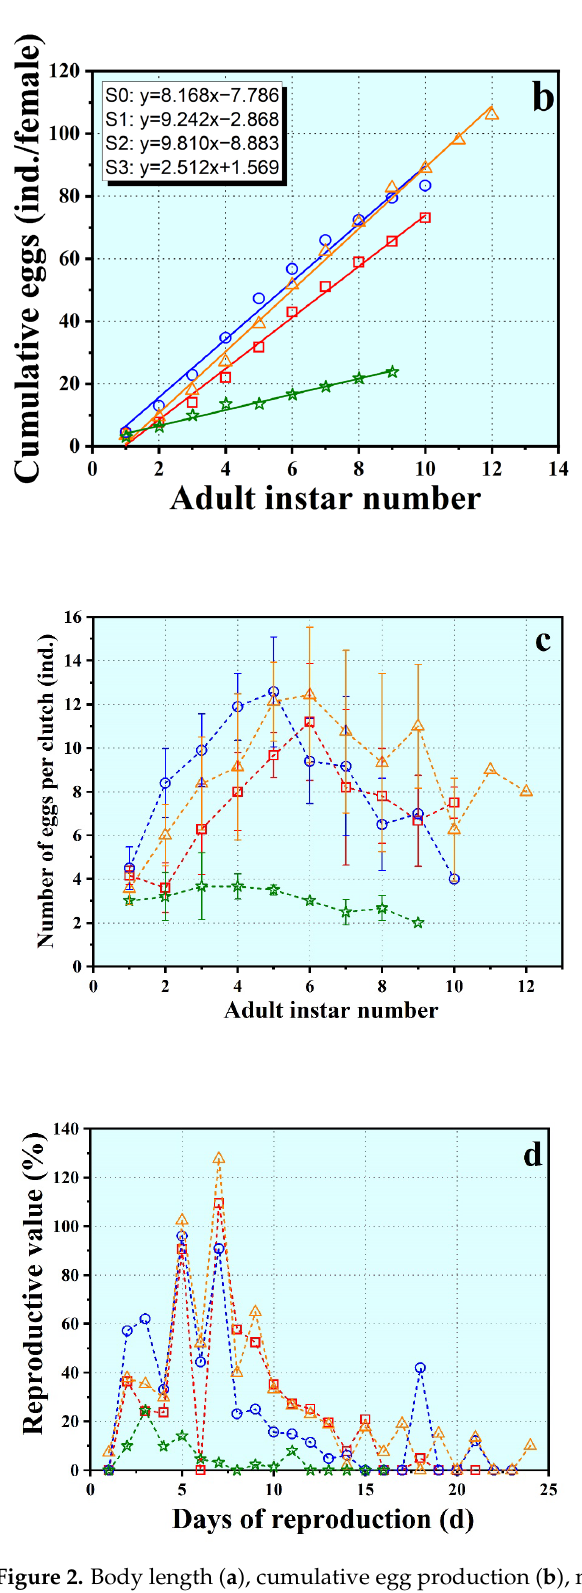
Figure 2. Body length ( a ), cumulative egg production ( b ), number of eggs per clutch ( c ) and repro- ductive value ( d ) of S. mucronata reared at different salinity gradients. Body length and number of eggs per clutch curves represent mean ( ± SE) values. S0, S1, S2, S3 and S4 represent control, 1, 2, 3 and 4,